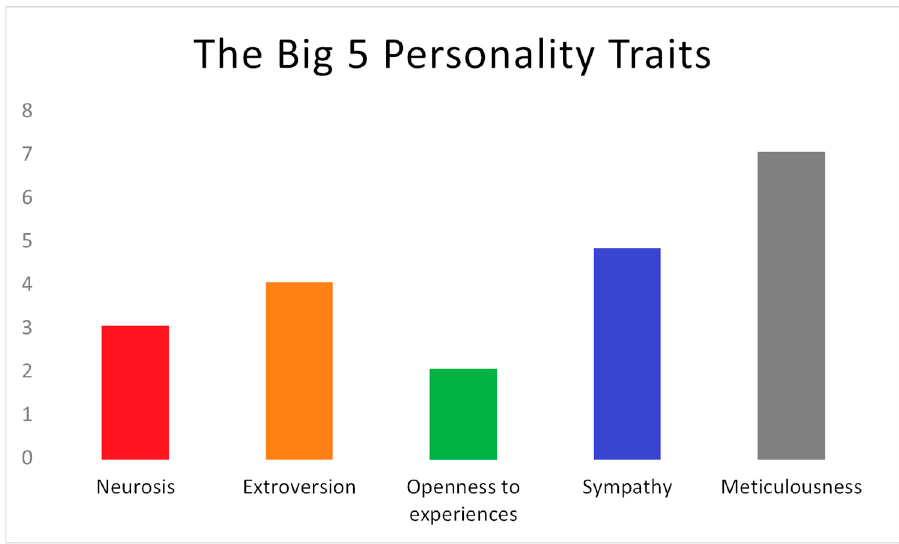
Figure 1. Result of the application of the test of the 5 major traits of personality to a population of 21 people.